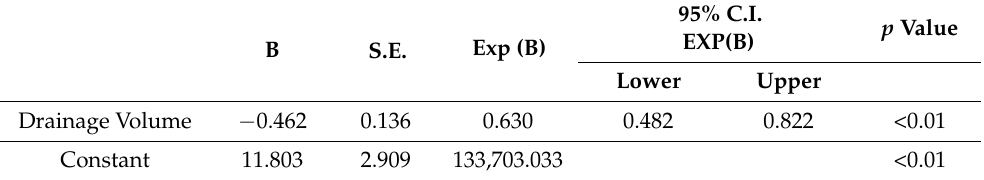
Table 4. Binary logistic